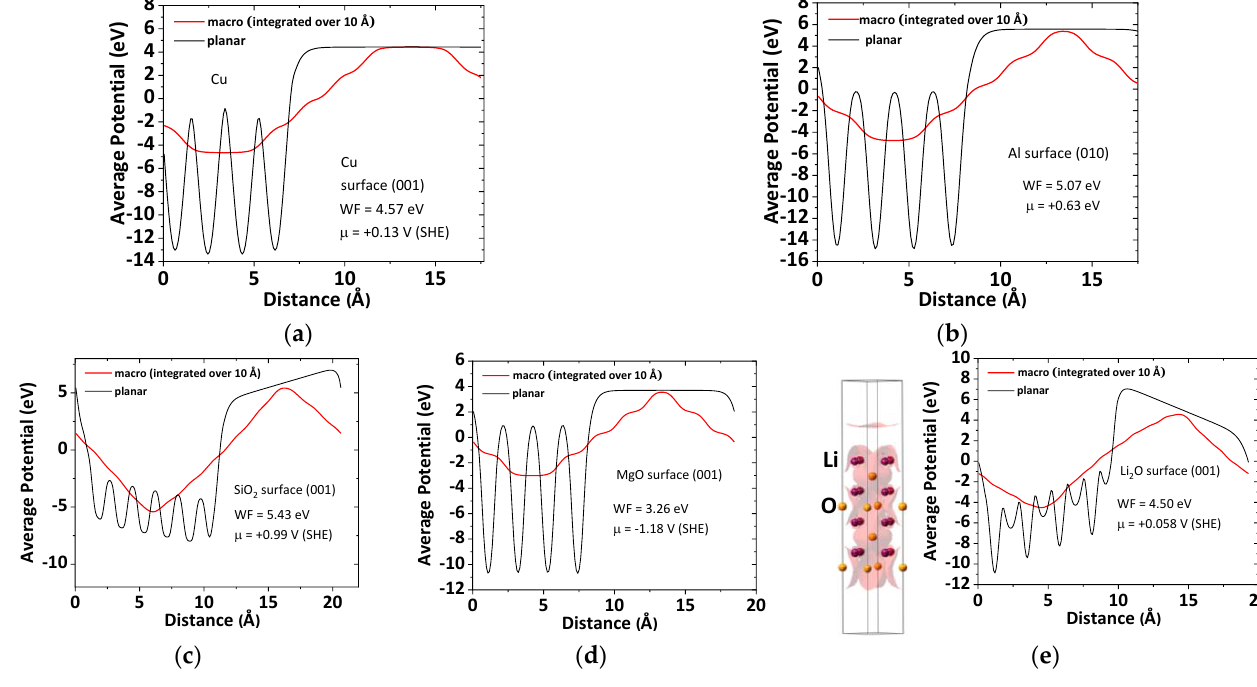
Figure 10. Ab initio : average potentials for metal electrodes and dielectrics were obtained after the simulation of the corresponding surfaces after optimization of the corresponding crystal structures. The macro potentials correspond to integration over 10 Å ; ( a ) for (001) simulated surface of Cu, and ( b ) for (010) simulated surface of Al; for (001) simulated surfaces of ( c ) SiO 2 ; ( d ) MgO; ( e ) Li 2 O. Note: The (001) surface average potential for Al was obtained in [31].